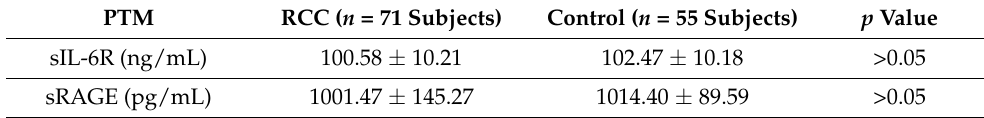
Table 5. Serum levels of sIL-6R and sRAGE in the studied groups.